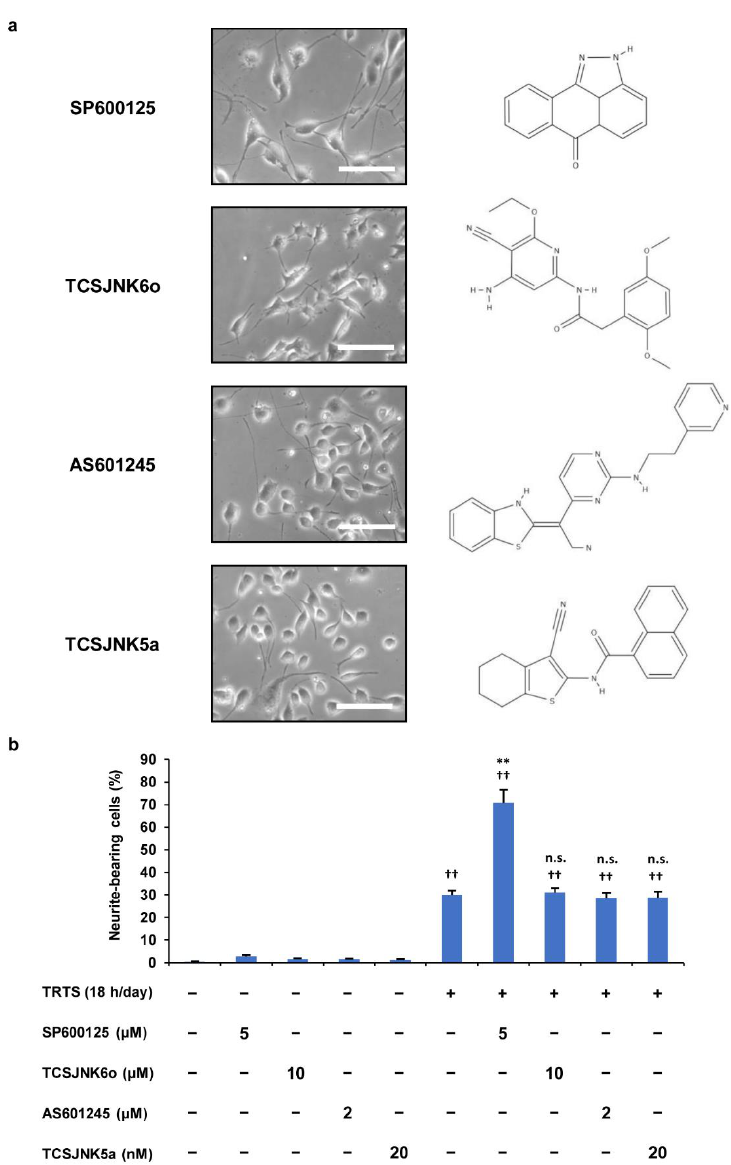
Figure 6. Effects of SP600125 and the other JNK inhibitors (TCSJNK6o, AS601245, and TCSJNK5a) on TRTS-mediated neuritogenesis in PC12-P1F1 cells. PC12- P1F1 cells were pretreated with 5.0 μM SP600125, 10 μM TCSJNK6o, 2.0 μM AS601245, or 20 nM TCSJNK5a and then exposed to TRTS for 18 h per day for 7 days. ( a ) Representative phase-contrast images of PC12-P1F1 cells on day 7 in the presence of TRTS and the chemical structures of the indicated JNK inhibitors. Scale bars: 100 μM. ( b ) The percentage of neurite-bearing cells on day 7 was counted using microscopy. The data rep- resent the means ± standard deviation of three replicates. †† p < 0.01 vs. control; ** p < 0.01 vs. TRTS alone; n.s., not significant vs. TRTS alone.